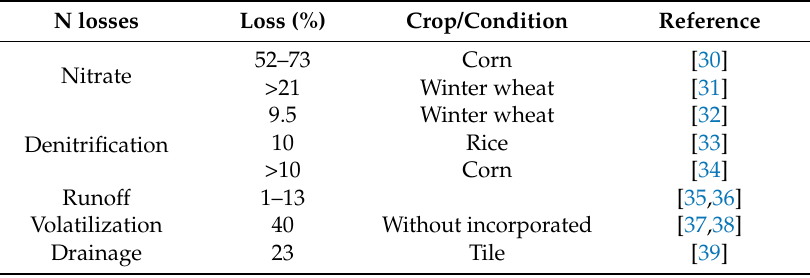
Table 2. Losses of N fertilizer in cereal crops.